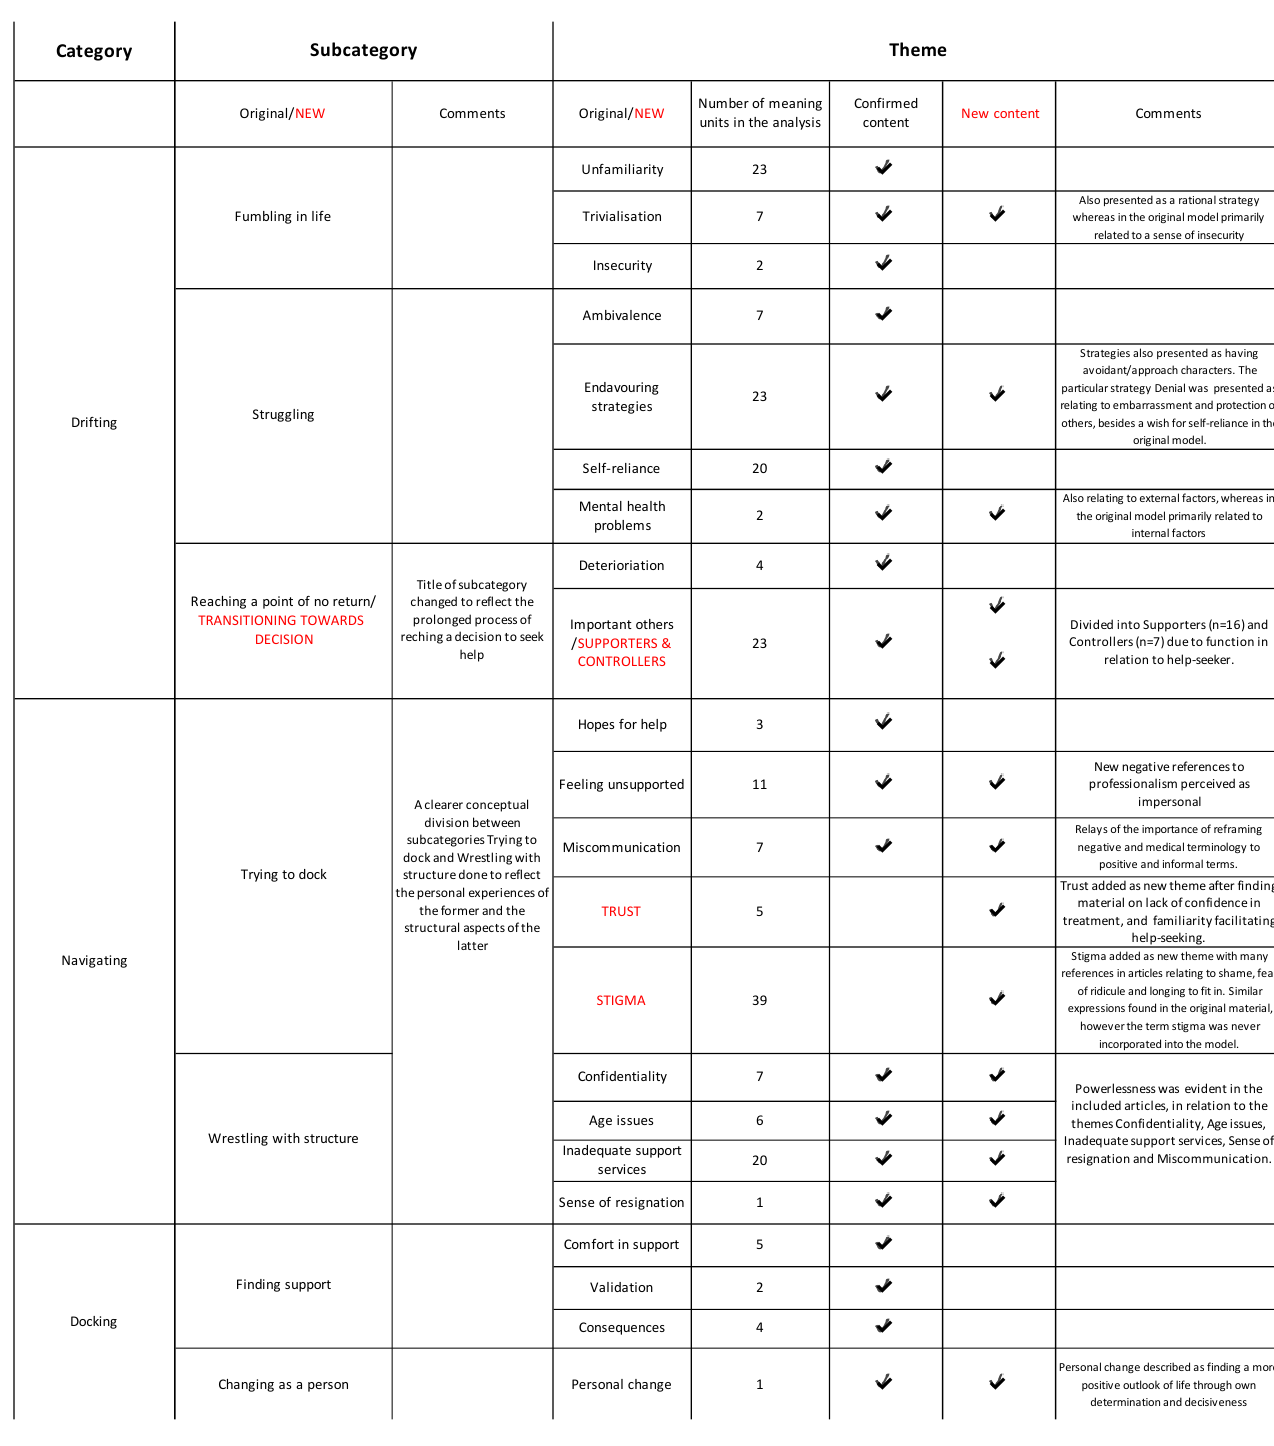
Figure 2. Examination of the help- seeking process from young people’s perspectives.